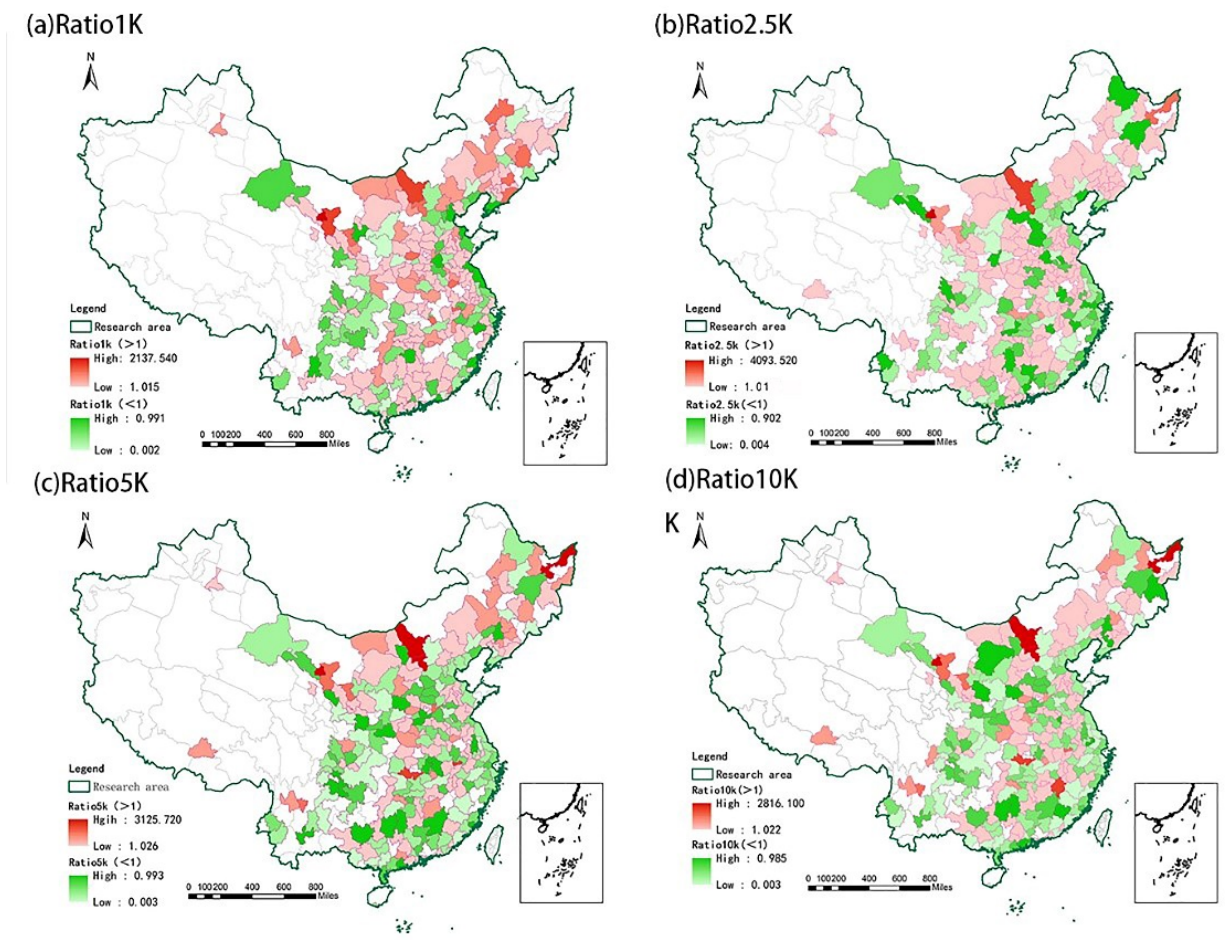
Figure 3. Comparison of 2SFCA and traditional accessibility method when ( a ) d 0 = 1 km; ( b ) d 0 = 2.5 km; ( c ) d 0 = 5 km; and ( d ) d 0 = 10 km.